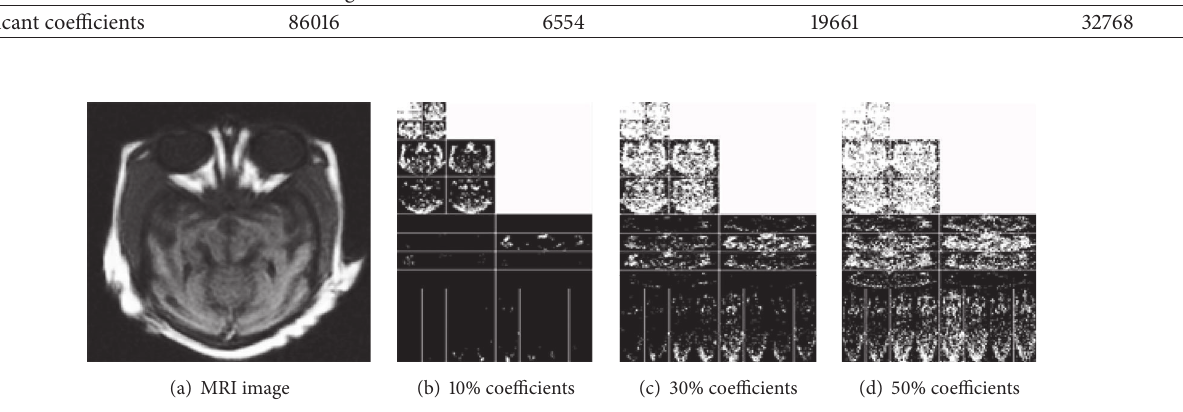
Figure 1: Nonlinear approximation of contourlet.